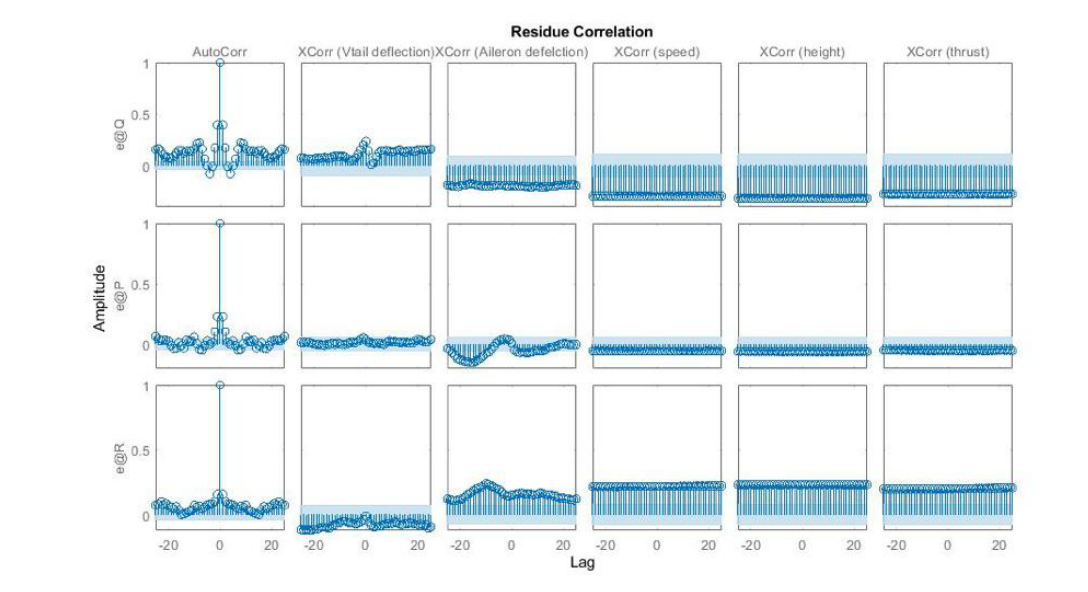
Figure 19. SS Model Residue Correlation.